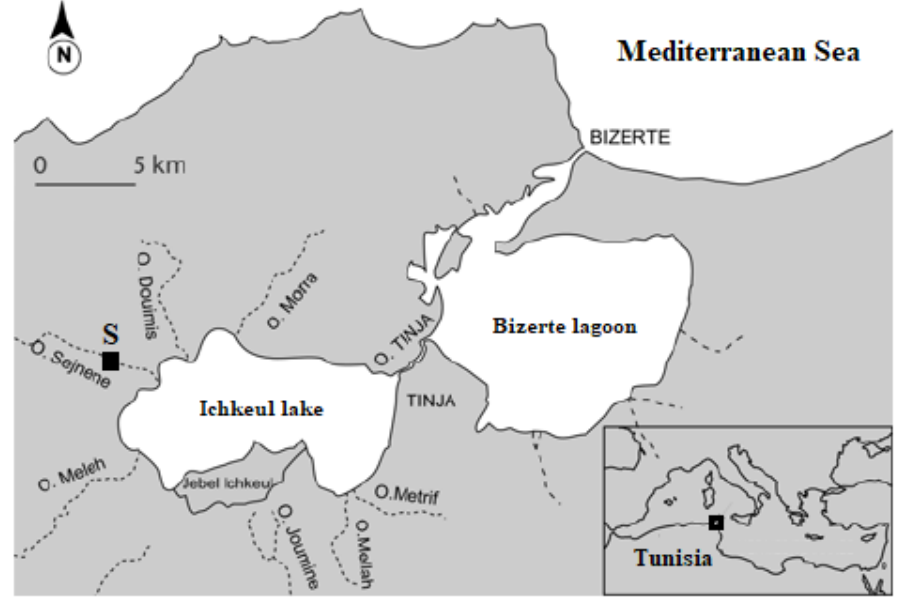
Figure 1. Collection site (S) of the freshwater bivalve Unio ravoisieri . Oued (O).